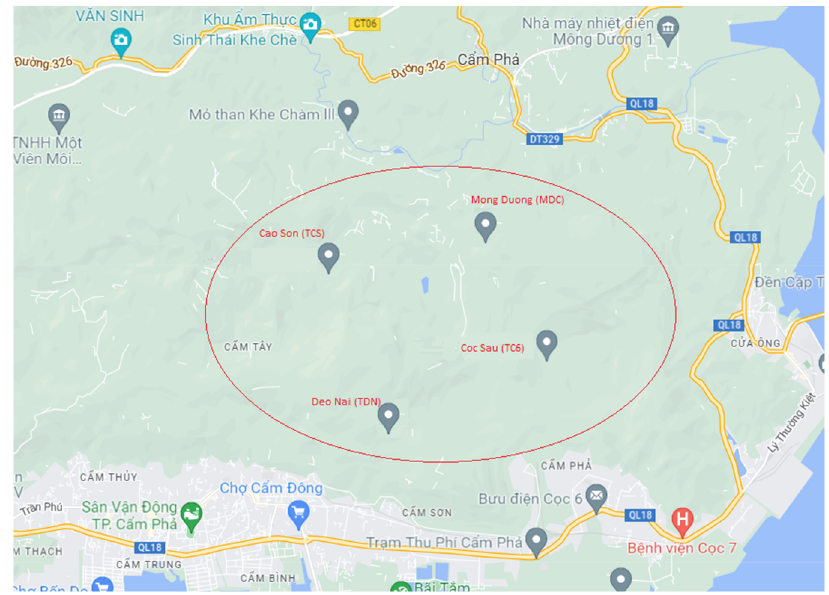
Figure 2. Locations of the Cao Son, Mong Duong, Deo Nai and Coc Sau coal mines. Source: Google map.